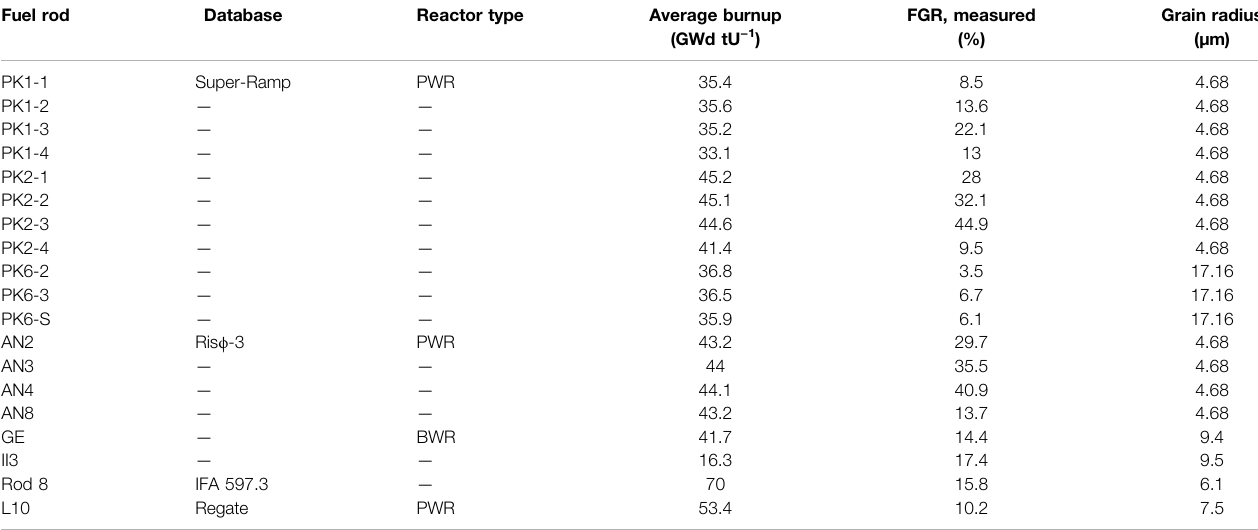
TABLE 5 | Summary of irradiation experiments from the OECD/NEA IFPE database analyzed in Barani ’ s work (Barani et al., 2017). Fuel rod